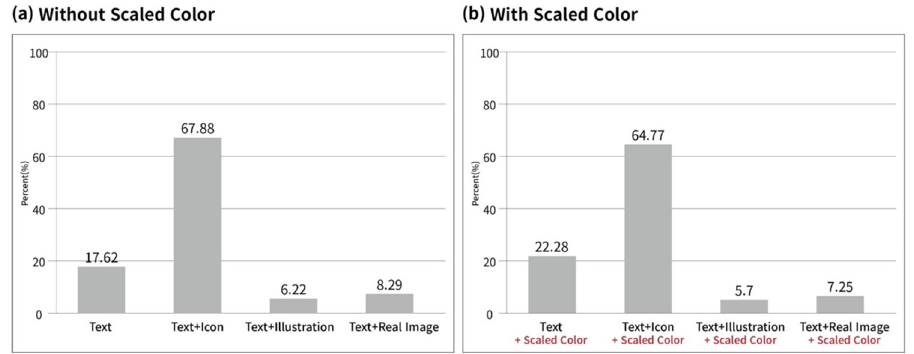
Fig 3. Proportion of most helpful to understand the symptoms among the graphical user interface (GUI) designs. (a) Without Scaled Color, (b) With Scaled Color.